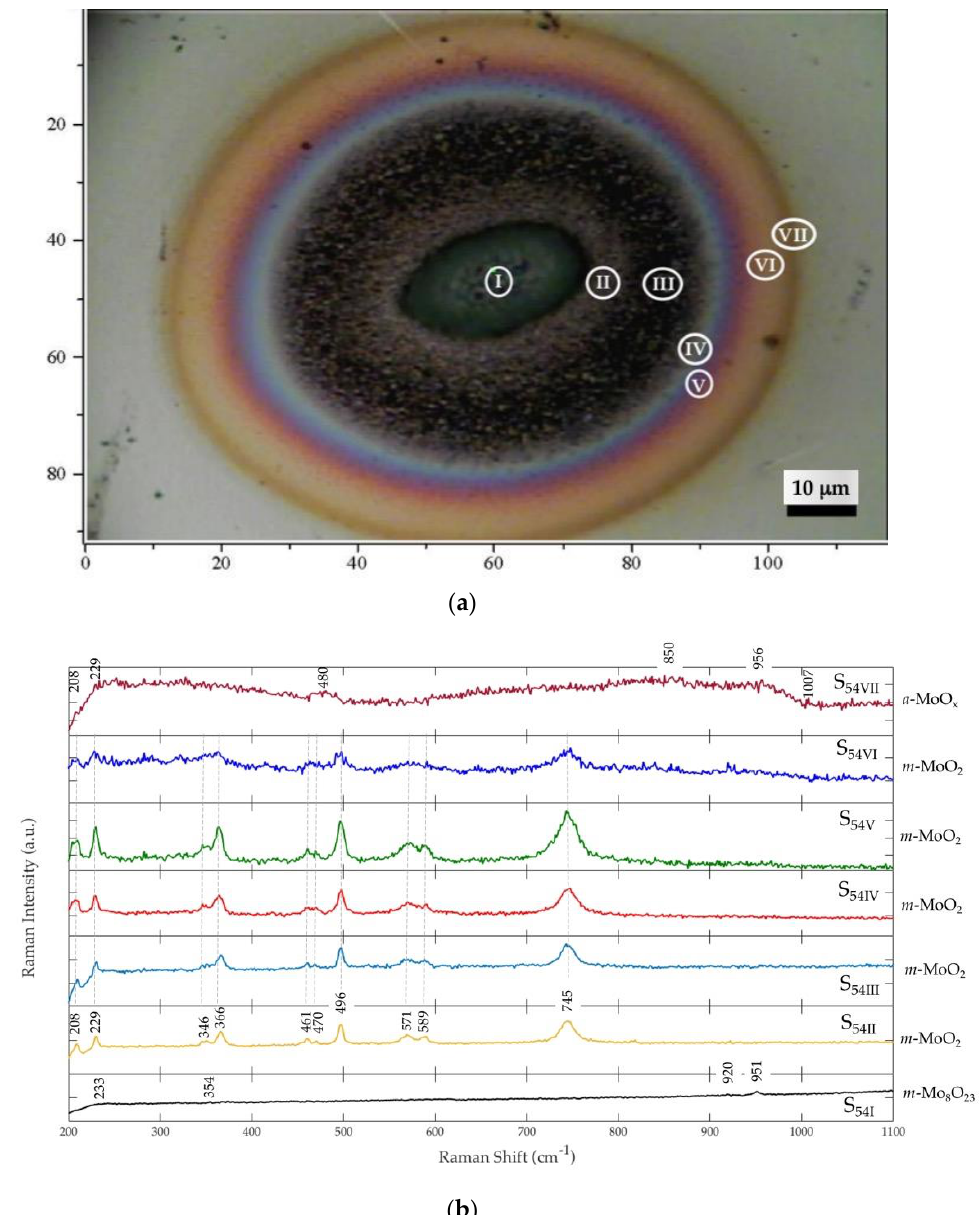
Figure 5. Optical micrograph ( a ) with I–VII the positions where Raman measurements were taken, and spatially resolved Raman spectra ( b ) for the irradiated spot S 54 at per-pulse laser fluence 3.6 mJ/cm 2 and 30 s exposure time.